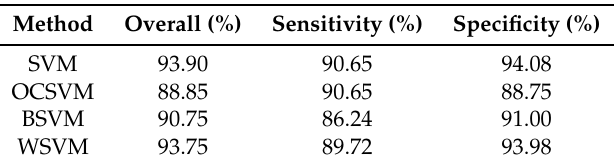
Table 2. Overall accuracy, sensitivity, and specificity for each method. Results are in percentage.